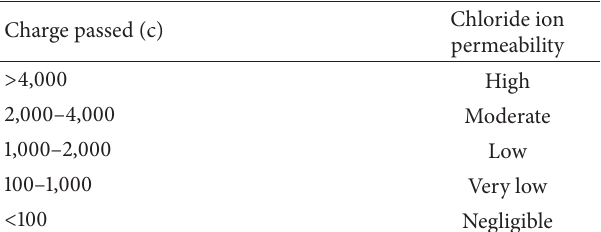
Table 3: Chloride ion penetrability based on charge passed [38]. Charge passed (c)